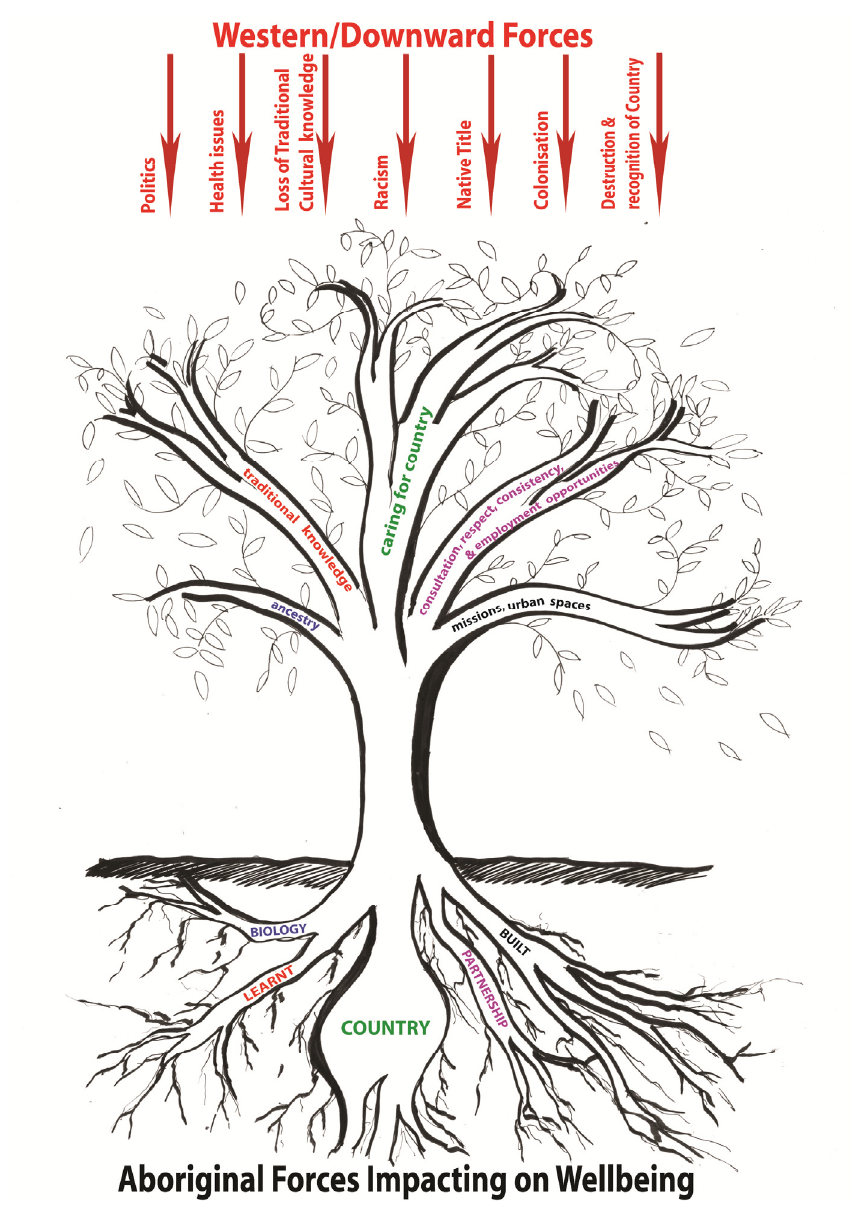
Figure 4. Exploratory Framework for Aboriginal Victorian peoples’